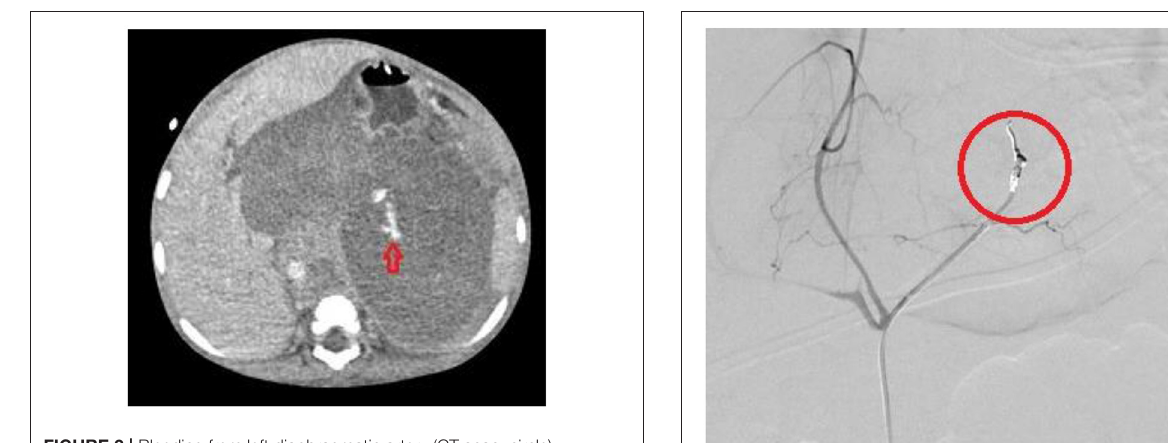
FIGURE 2 | Bleeding from left diaphragmatic artery (CT scan: circle).